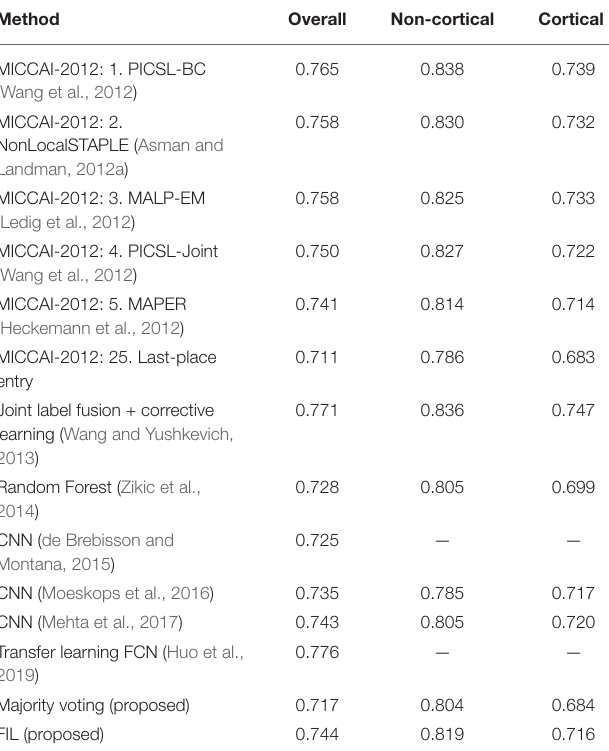
TABLE 2 | Average Dice-Sorenson coefficients (DSC) across testing subjects using the proposed method in comparison with published methods, including the top three approaches from the MICCAI